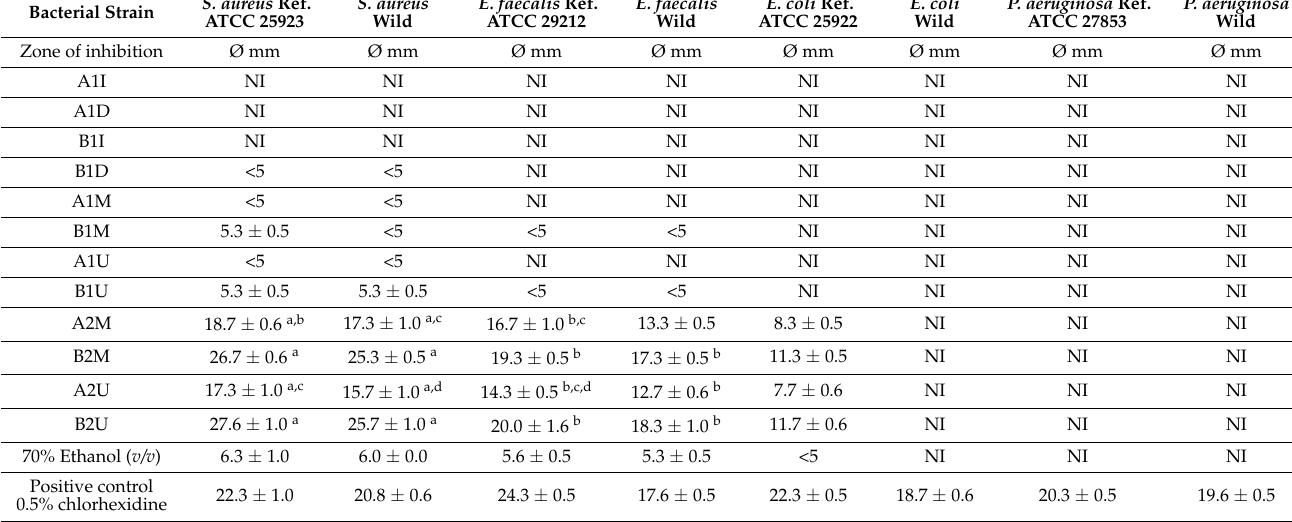
Pairwise comparisons using a Student’s t -test were performed for each pair of bacterial strains for each extraction method separately. The shared letters in superscript indicate that there was no statistically significant difference between the concentrations ( p >